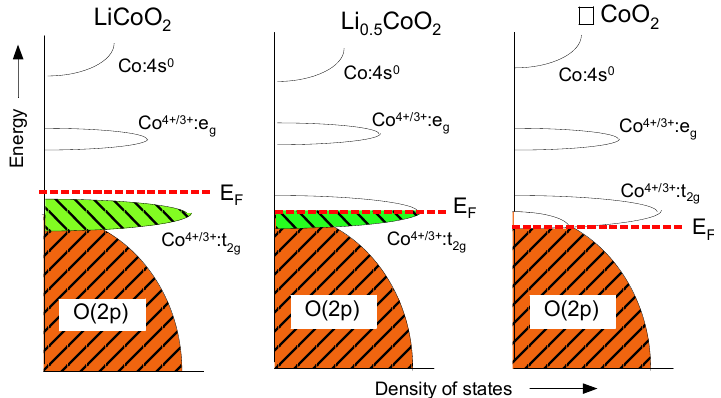
Figure 9. Change of the qualitative energy diagrams of Li lithium content. From left to right: x = 1, x = 0.5, x =